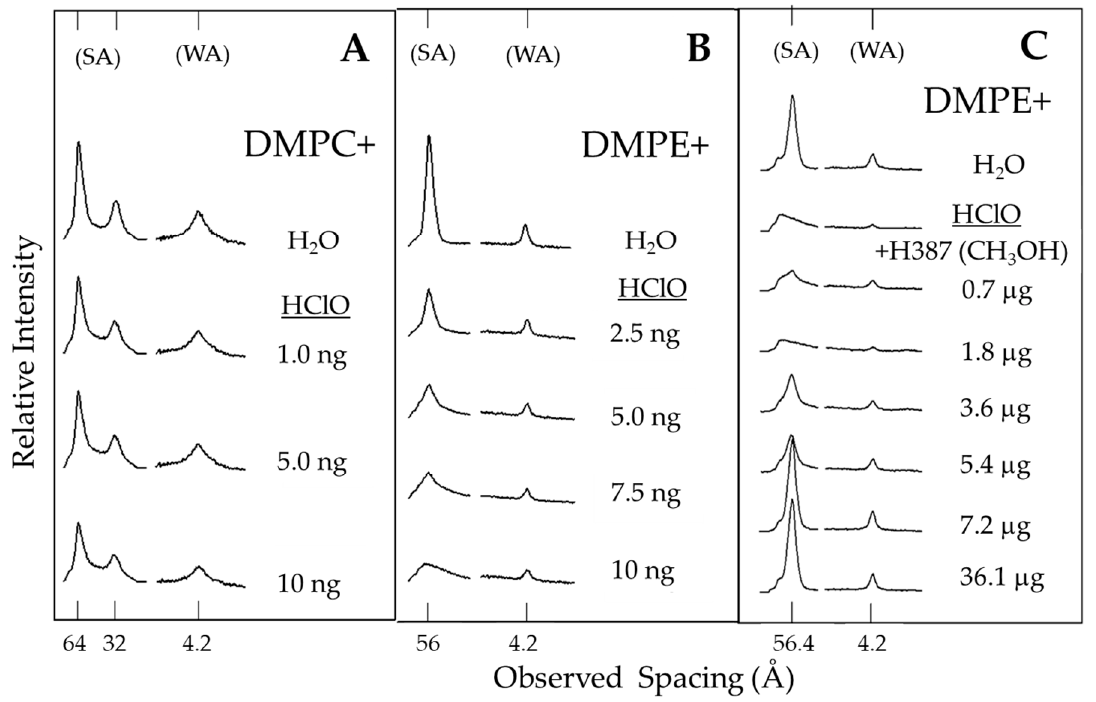
Figure 4. X-ray di ff raction patterns of ( A ) dimyristoylphosphatidylcholine (DMPC) and ( B ) dimyristoylphosphatidylethanolamine (DMPE) bilayers immersed in water and hypochlorous acid (HClO); ( C ) DMPE in water in the presence of or absence of HClO 10 ng / mL, and with increasing concentrations of the extract of H387 07 hybrid; small-angle (SA) and wide-angle (WA) reflections. 2.4. Phenolic Compounds from Sechium H387 07 Fruit Extract that Enter The Bloodstream